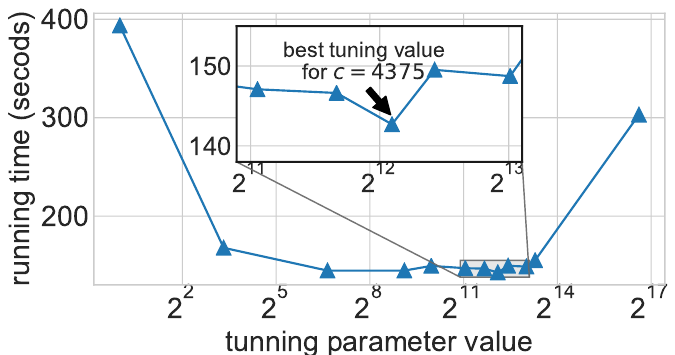
Figure 1. Tuning parameter search. Every point is the (arithmetic) mean running time for all the instances in the tuning set. Experiments on each instance are repeated 3 times for the respective value of the parameter. The value that gives the best results is picked; here it is 4375.0 as it provides the lowest running time of about 165.2 s.